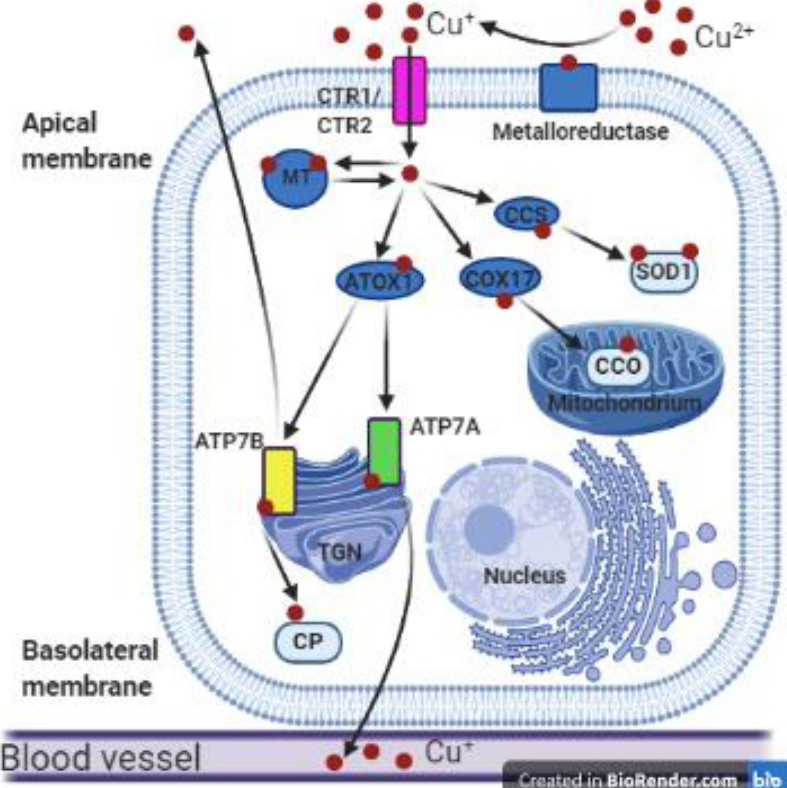
Figure 1. Copper metabolism in polarized mammalian cells. Cupric ions (Cu 2+ ) are reduced to cuprous ions (Cu + ) by metaloreductase and can then be transported into the cell by the transmembrane transporters CTR1 or CTR2. In the cytosol, Cu + ions can be reversibly bound by metallothionein (MT) and stored in the Cu-MT complex. In the cytoplasm Cu + ions are bound by cytosolic metallochaperones: copper chaperone for superoxide dismutase 1 (CCS), COX17, and ATOX1, which deliver copper to various proteins such as superoxide dismutase 1 (SOD1), cytochrome c oxidase (CCO), ATP7A, and ATP7B. As a result, copper is delivered to different cellular compartments such as the cytoplasmic reticulum, mitochondria, or the Golgi apparatus. The ATP7A and ATP7B proteins located in the trans-Golgi network (TGN) incorporate Cu + ions into the apoenzymes. ATP7B can transfer copper to apo-ceruloplasmin (CP) to form holo-ceruloplasmin. Then copper in the complex with